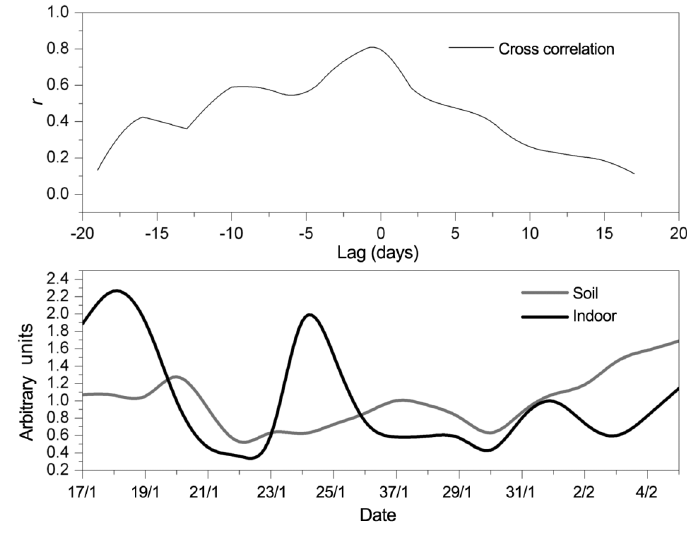
Fig. 4. Cross-correlation (upper plot) between soil and indoor radon trend (down plot) site of Ragusa